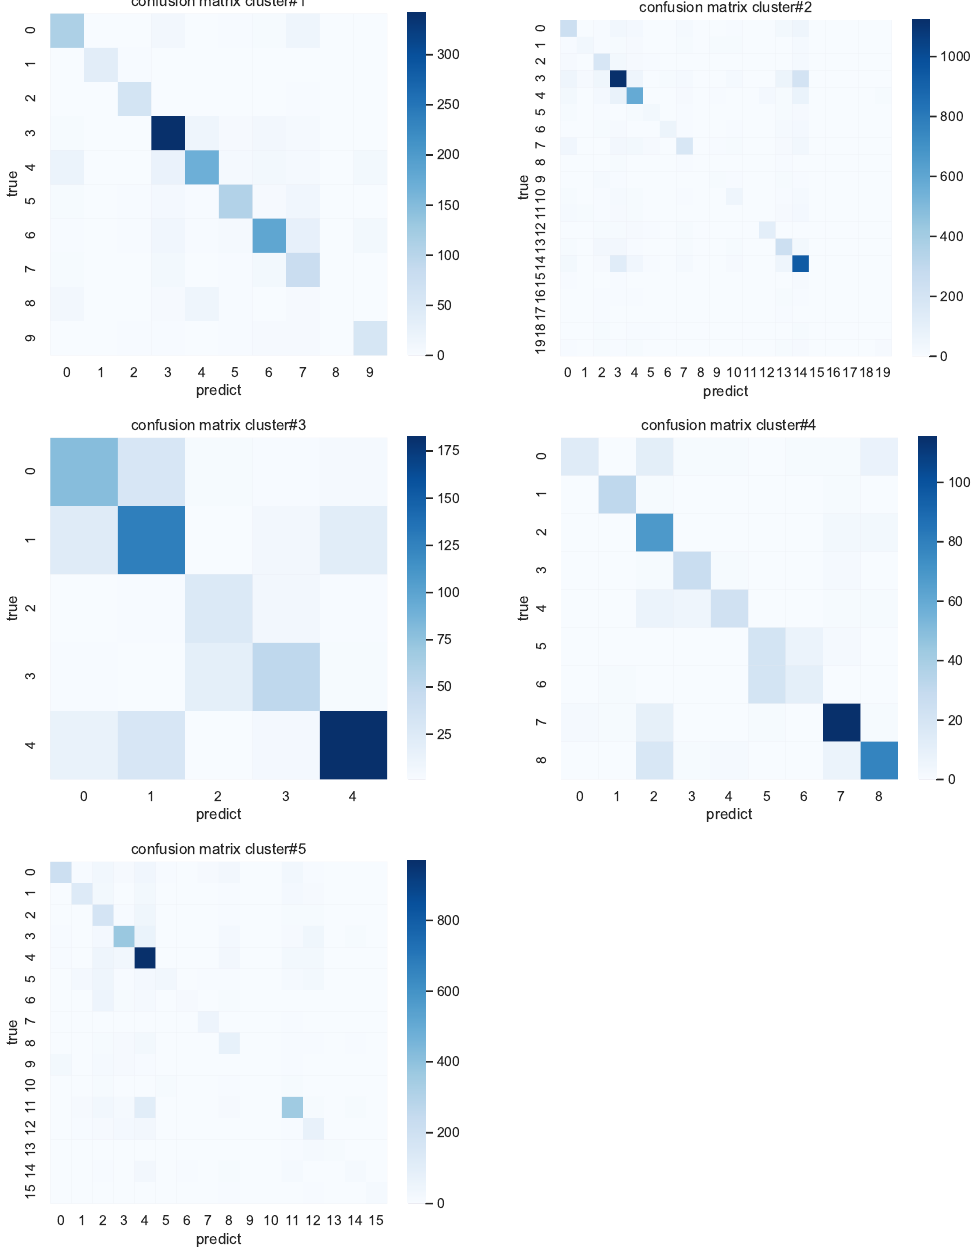
Figure 7. Confusion matrix of each